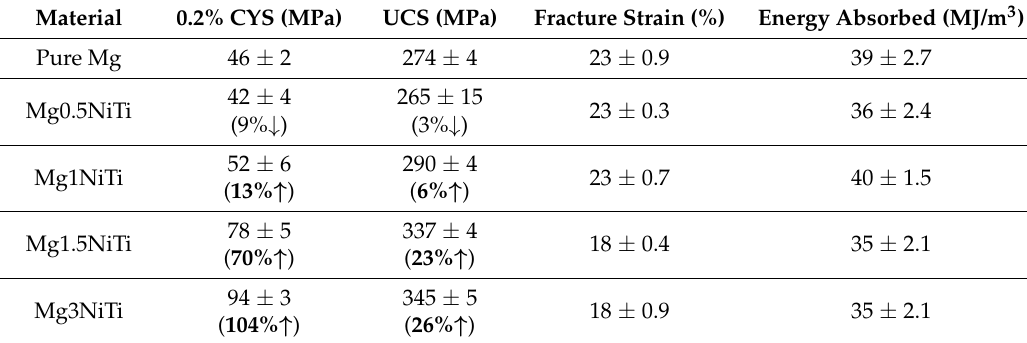
Table 4. Room temperature compressive testing